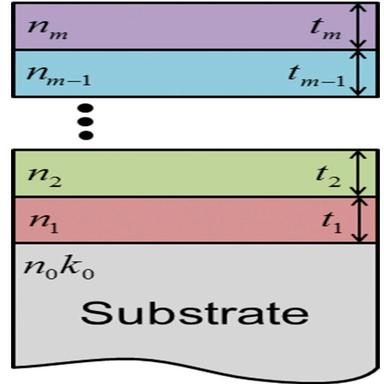
Model structure for a multi-layer coating. Each transparent material is represented by its thickness (t) and index of refraction (n), while the substrate is represented by its complex refractive index (n and k).